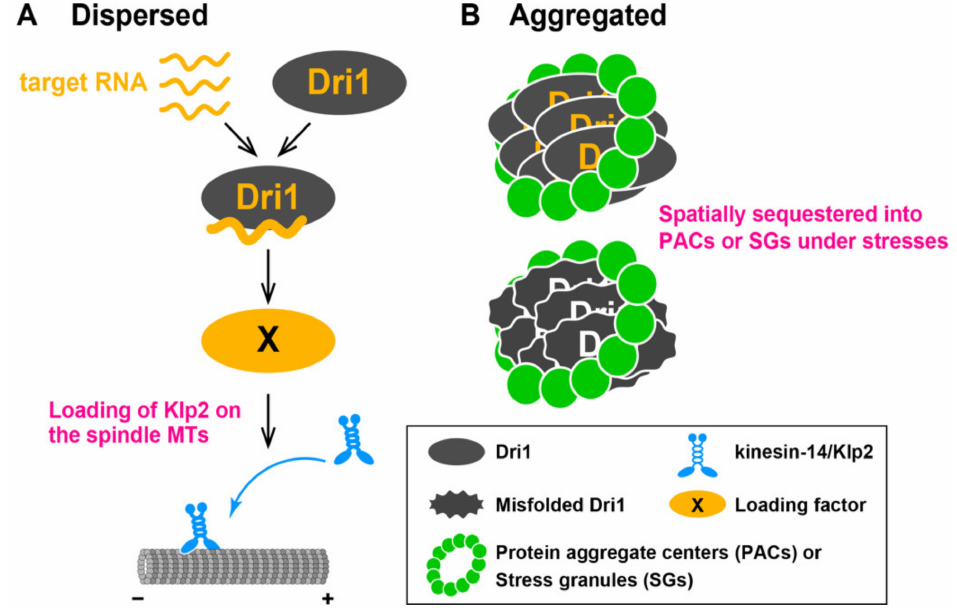
Figure 7. Schematic model of the role for Dri1 in bipolar spindle assembly and growth at high temperatures. ( A ) Under normal growth condition, Dri1 displays dispersed cytoplasmic patterns and acts to load kinesin-14/Klp2 on the spindle microtubules through its RNA-binding activity. Dri1 is shuttled between the cytoplasm and the nucleus by means of its RNA-binding activity. Dri1 might be involved in the processing of its target mRNA, which encodes an unidentified loading factor (X) of Klp2 onto the spindles. ( B ) Under mild heat stress, Dri1 is spatially sequestered by PACs, thereby leading to down-regulation of its function in bipolar spindle assembly. Dri1 is also important for limiting cell growth at 39 ◦ C. In the absence of Dri1, cells manage to divide at 39 ◦ C; however, these cells are not healthy and tend to undergo lysis upon cell separation. At higher temperature (42 ◦ C) or under other adverse stresses, Dri1 is incorporated into SGs. Dri1 proteins localizing to PACs and SGs might be misfolded, by which they bind chaperones that are components of these aggregates. For simplicity, the role of Dri1 involving heterochromatin formation via histone deacetylase and RNA interference pathways [62] is not included in this